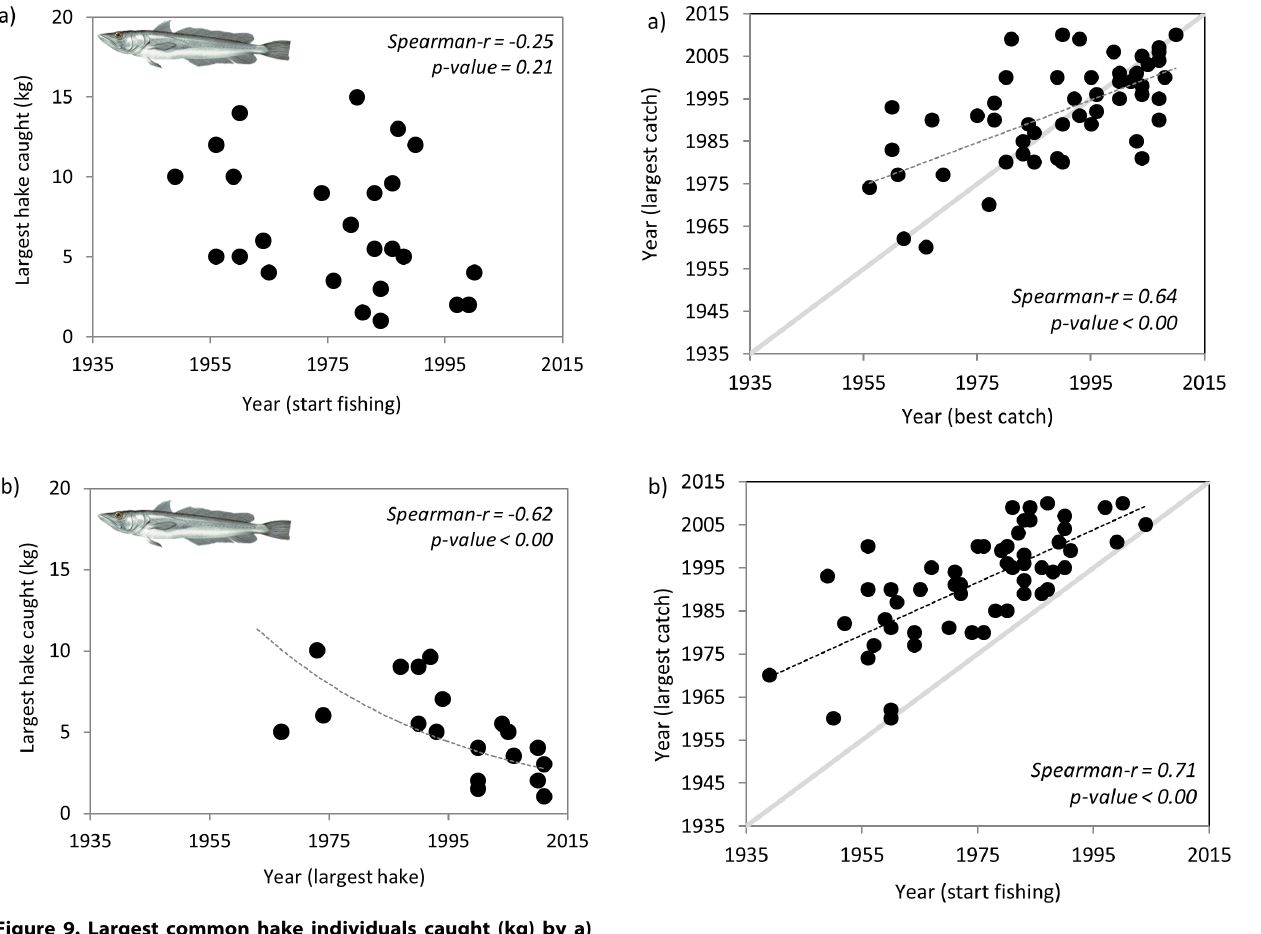
Figure 10. Assessment of the a) year of the best catch and of the largest caught species, and b) year at starting fishing and the largest caught species. Diagonal grey line represents the x=y